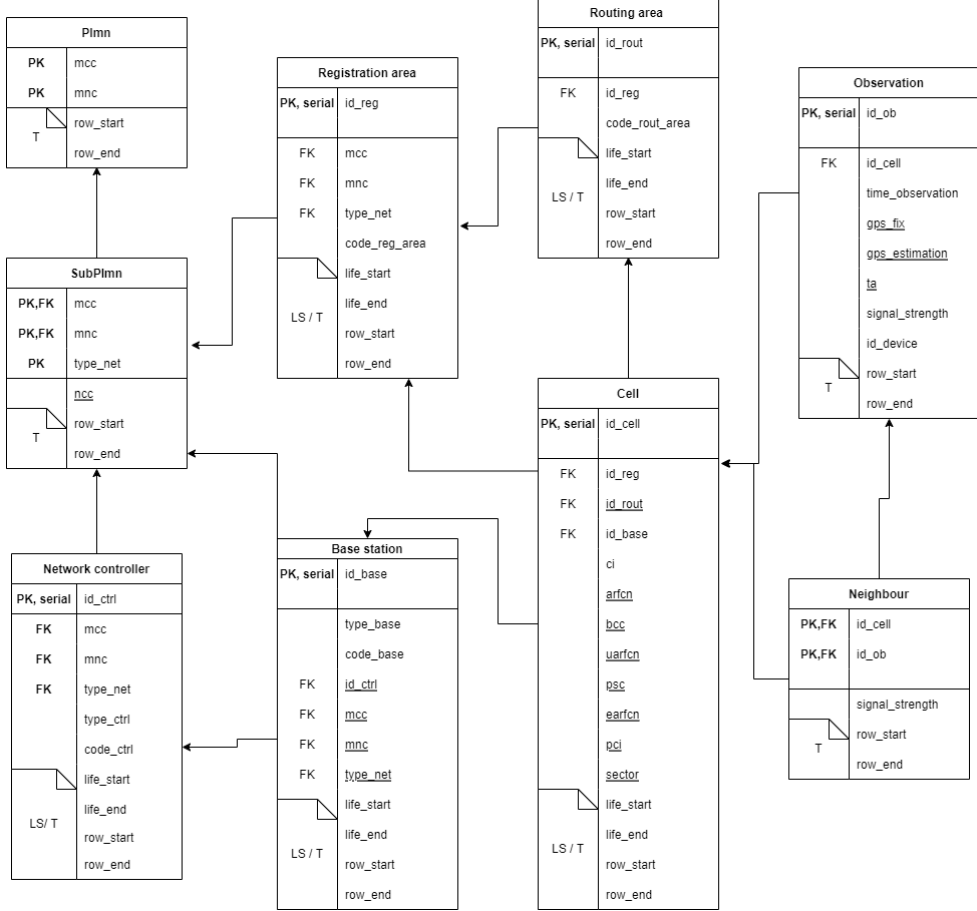
Figure 8. Relational logical model. Underlined attributes can take NULL values. Attributes life_start and life_end (resp., row_start and row_end ) represent the extremes of the valid time interval (resp., transaction time). Primary key and foreign key attributes are denoted by PK and FK, respectively. The keyword ‘serial’ highlights the surrogate